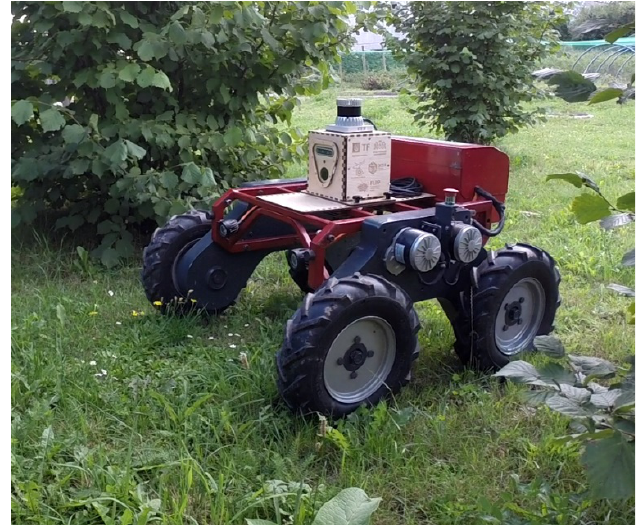
Fig. 3. Platform with sensor bundle mounted during recording.